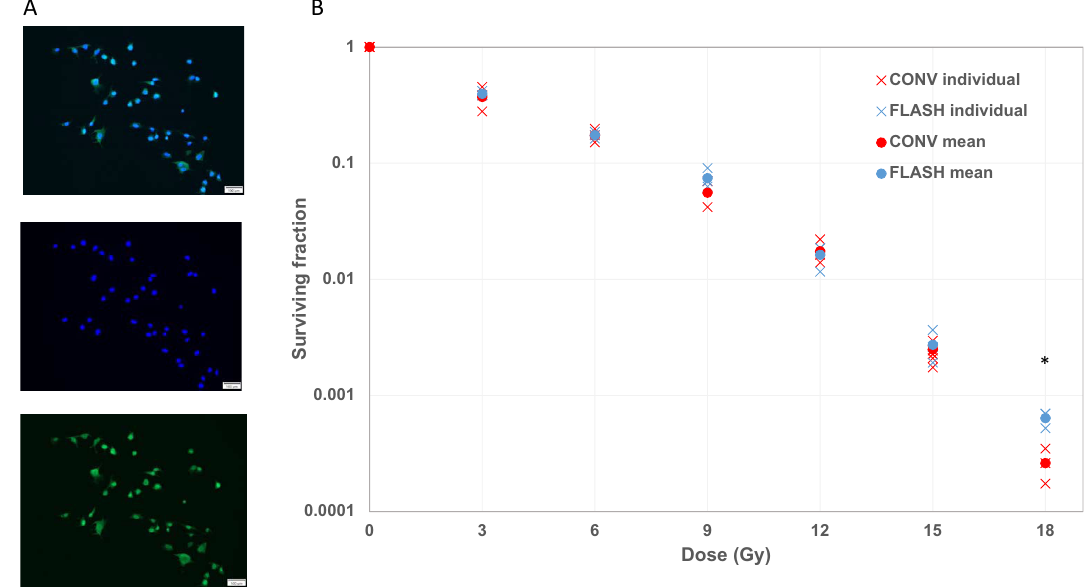
Figure 1. NS1 Glioblastoma cells and in vitro response to irradiation. ( A ) The NS1 rat glioma cell line used in the present study. Tumor cells are marked with dapi for nuclear staining (blue). GFP signal stands for the autofluorescence (green). ( B ) In vitro data exploring colony forming assay in relation to increased doses of CONV-RT or FLASH. Doses in the range 0–21 Gy were used for each modality. * indicates significant differences between CONV-RT and FLASH. At 21 Gy, no colonies were detected.